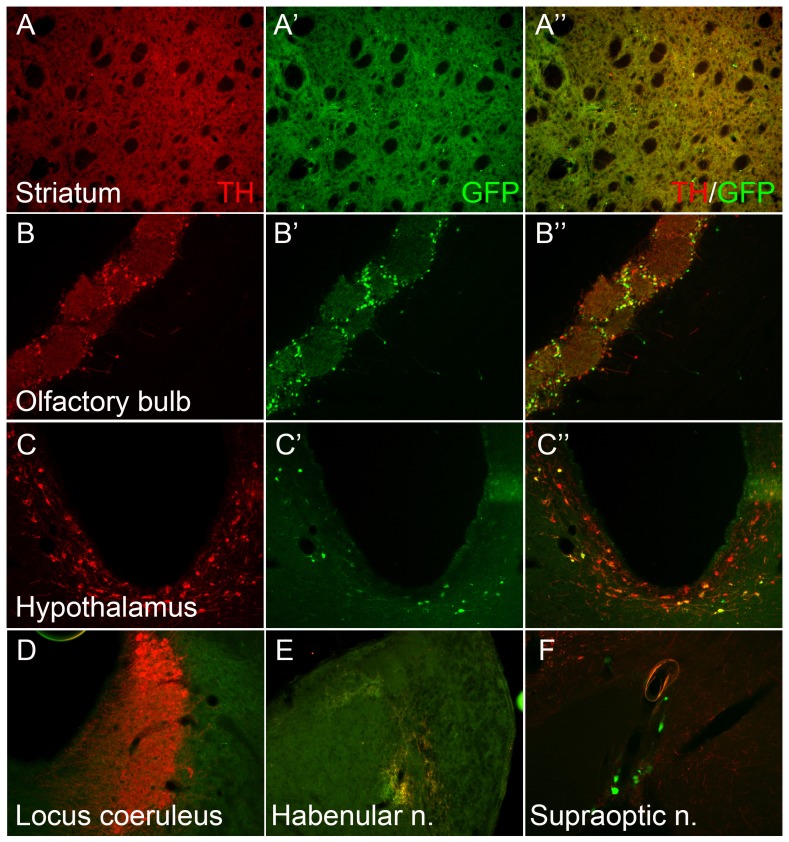
hTH-GFP expression correlates with TH expression in some but not all DA target regions.TH staining co-labels with GFP expression in adult striatum (A-A″) and olfactory bulb (B-B″) in Line 12141. However, GFP expression was less evident in the hypothalamus (C-C″) and absent in the locus coeruleus (D) despite robust TH staining. Ectopic GFP expression is seldom observed in non-TH expressing areas such as habenular nucleus (E) and supraoptic nucleus (F) in Line 12141.